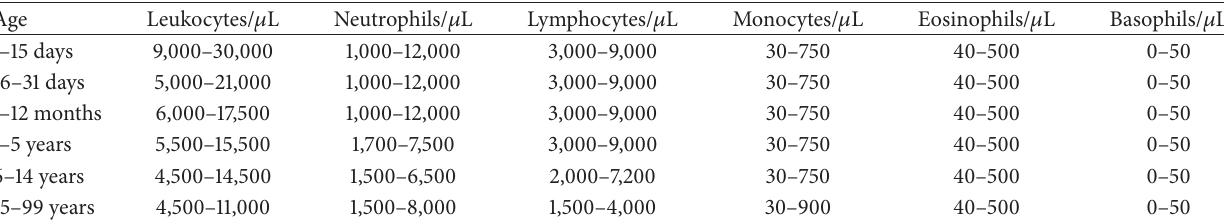
Table 1: Leukogram reference values by age ∗ .